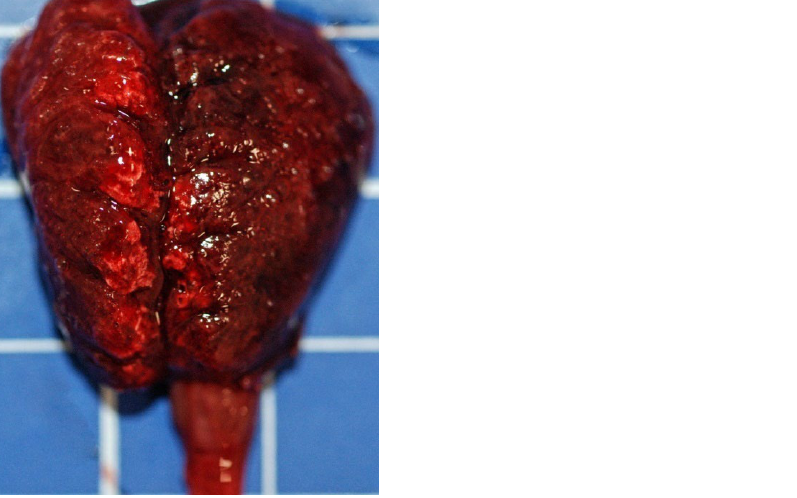
Figure 1. Gross photo of an Indian ringneck parrot’s lungs showing diffuse marked consolidation and congestion. Square = 1